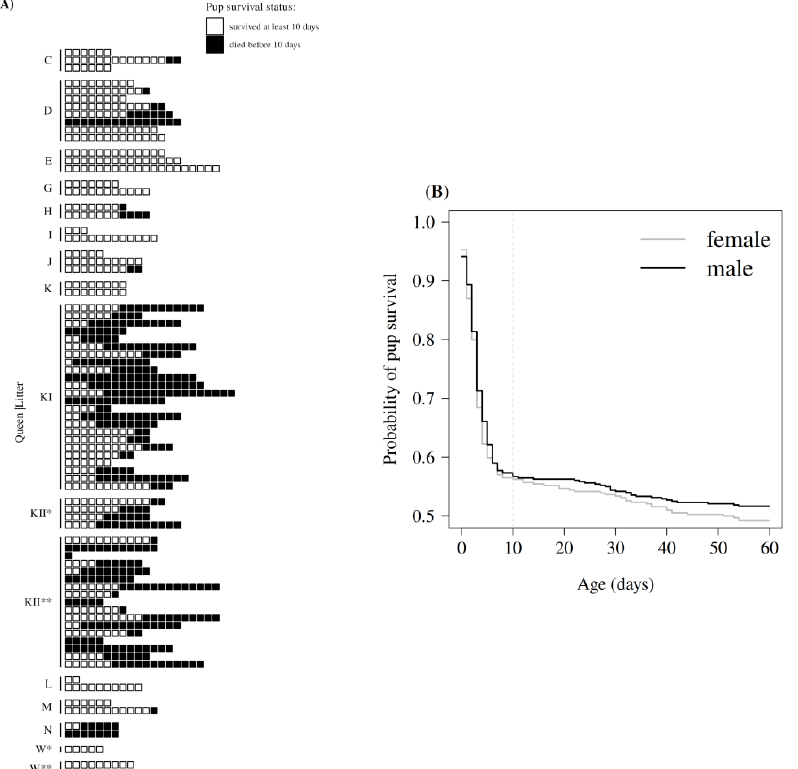
regressions, we converted the estimates into odds ratios in the text to facilitate interpreta- tion. P -values are computed for 2-tailed tests. Correlations were calculated accordingly as Spearman ’ s rank correlations.